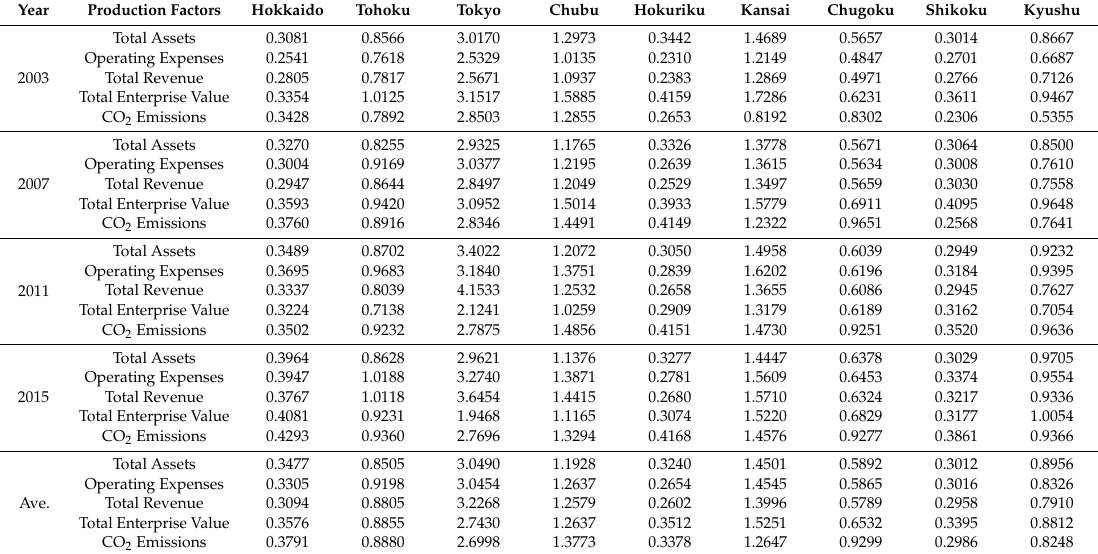
Table 3. Descriptive Statistics (2003–2015):